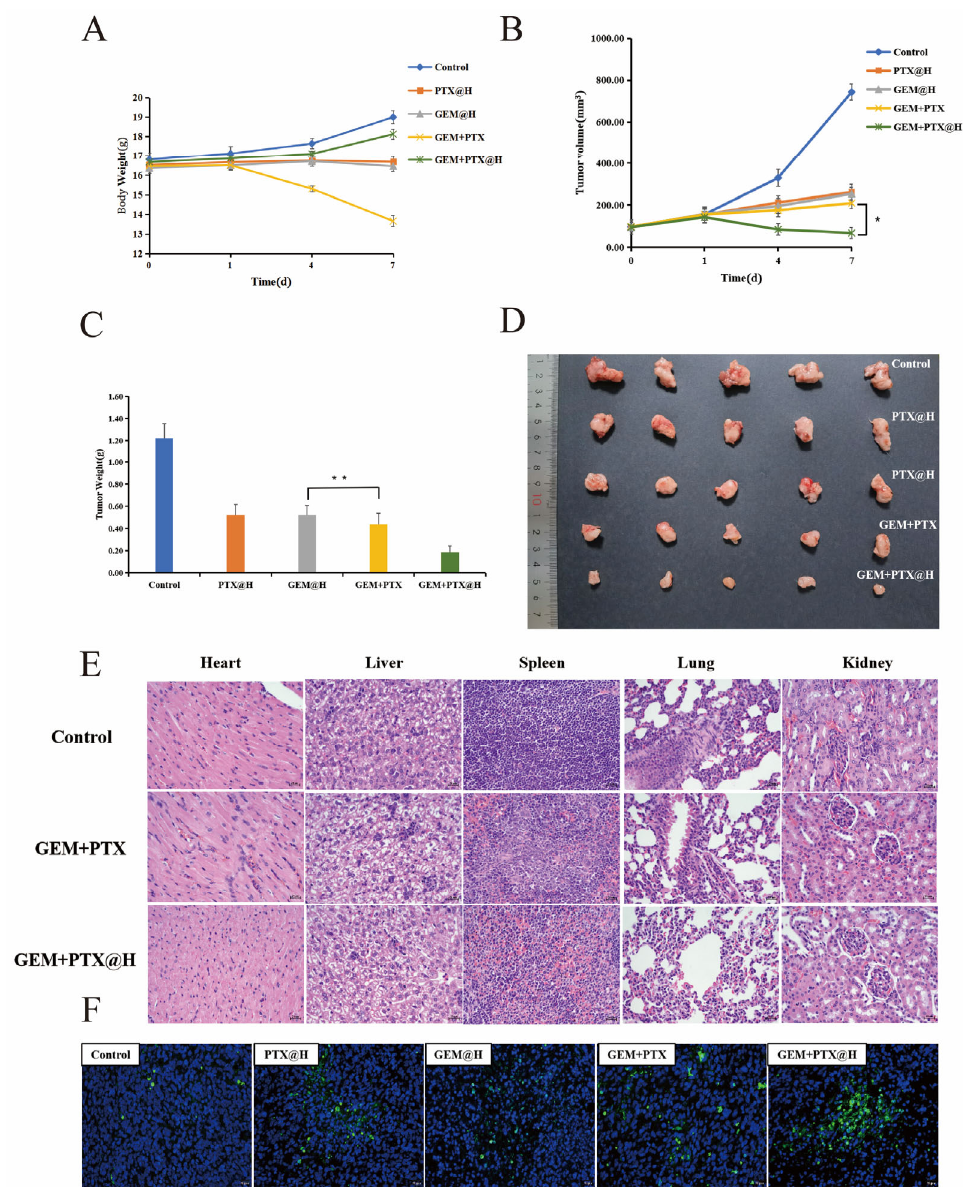
Figure 3. The body weight change curve of mice after administration ( A ). The tumor volume change curve of mice after administration ( B ). The tumor weight of mice 7 days after administration ( C ). Images of the tumors harvested from mice in the control group, the PTX@H group, the GEM@H group, the GEM+PTX group and the GEM+PTX@H group 7 days after administration ( D ). H&E ‐ based immunohistochemical images of five major organs harvested from the tumor ‐ bearing mice 7 days after administration ( E ). TUNEL ‐ based immunohistochemical images of the tumor harvested from a tumor ‐ bearing mouse 7 days after administration ( F ). * p < 0.1, ** p < 0.01.